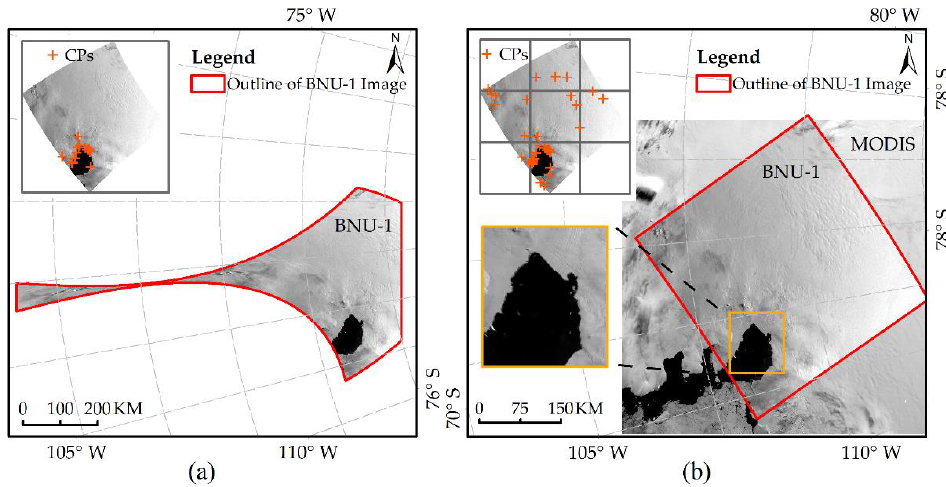
Figure 9. BNU-1 image after geometric correction of the BNU-1 L1A image using the CPs extracted from the original image ( a ) and scheme 2 ( b ). The corrected image with 50% transparency is superimposed on the corresponding MODIS image in ( b ).